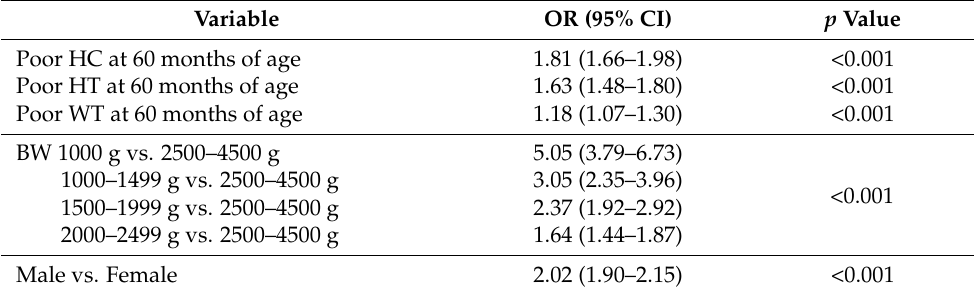
Table 4. Multivariate logistic regression analysis for the suspected development delay results at 60 months of